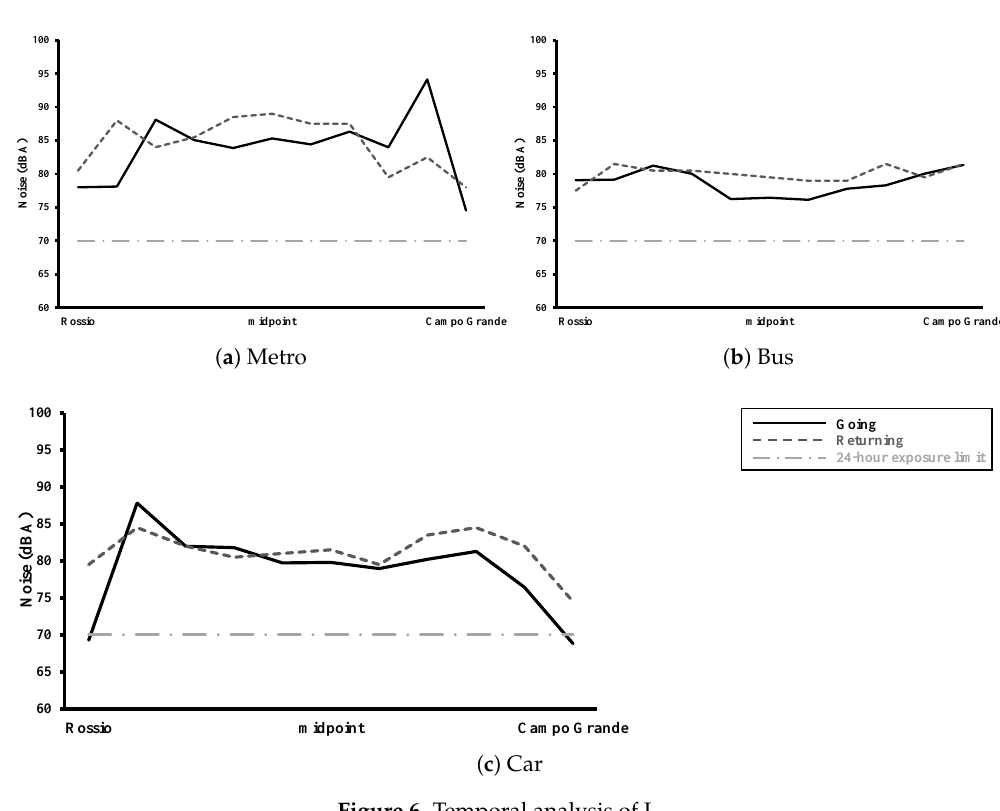
Figure 6. Temporal analysis of L eq . Table 2. Average values of L eq , L peak and L max in dBA for each mode of transportation and respective SD values (N =